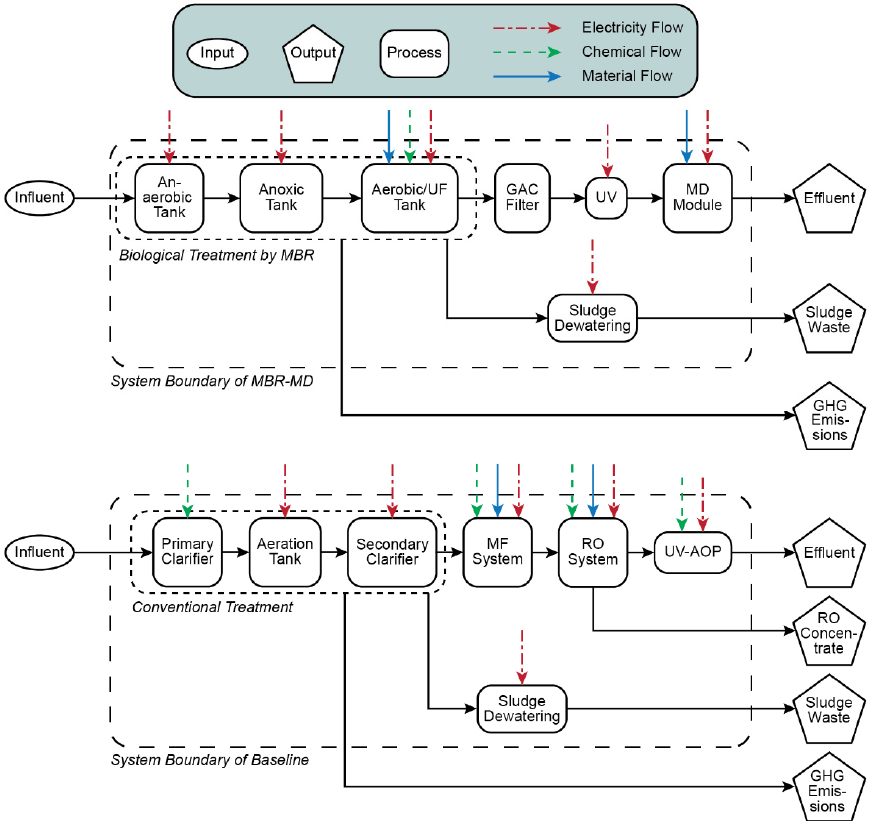
Figure 2. System boundaries of the MBR-MD and Baseline systems. Table 3. The complete LCI for the MBR-MD and Baseline systems based on a functional unit of 1 m 3 product